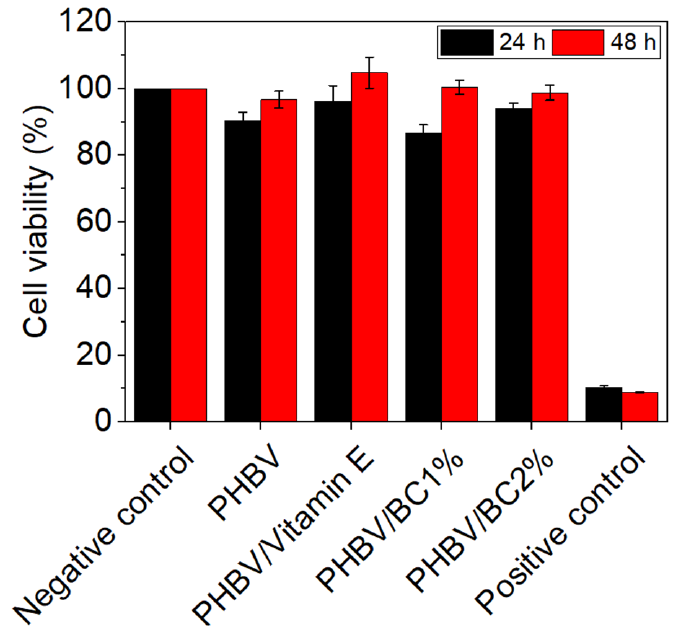
Figure 5. Viability of mouse NCTC fibroblasts cultivated in the presence of PHBV and BC biocom- posites for 24 and 48 h, evaluated by the MTT assay. Samples were reported to the negative control (untreated cells) considered to have a 100% viability. Data were expressed as mean values ± SD ( n = 3).